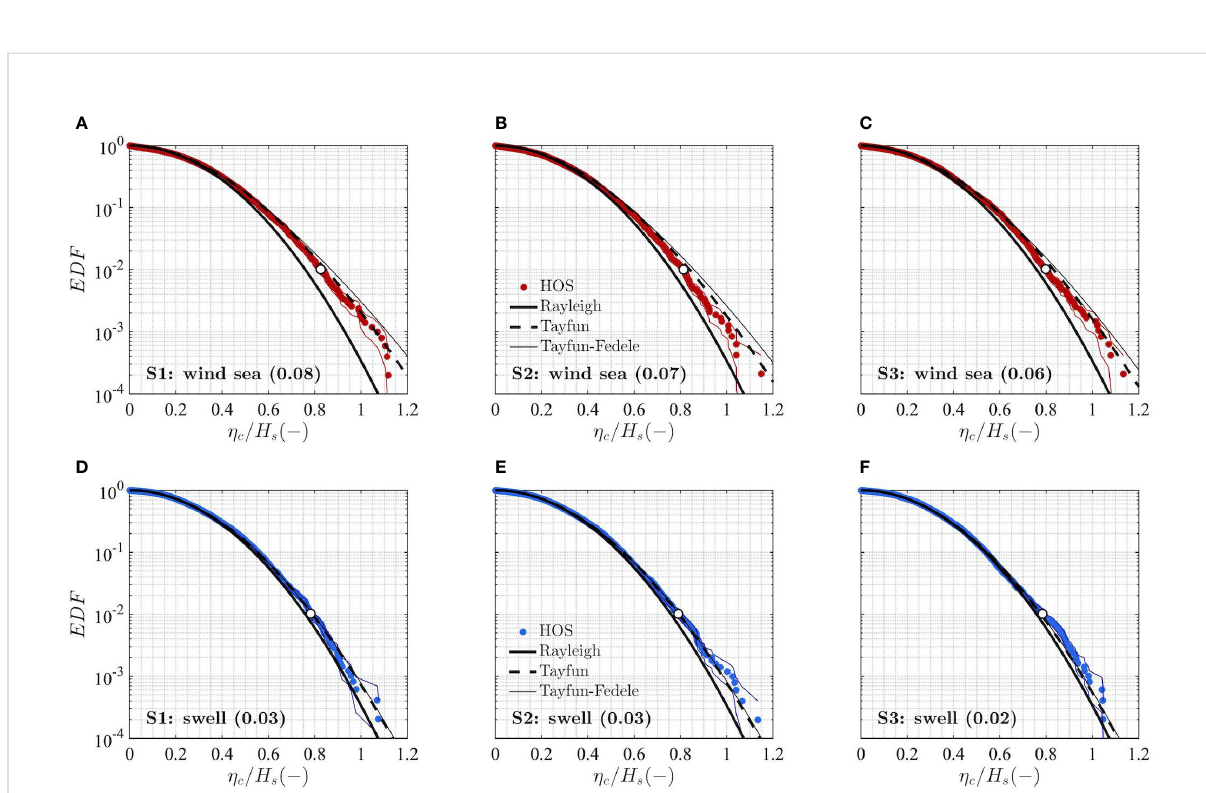
FIGURE 5 Empirical exceedance distribution functions of dimensionless crest heights ( h c /H s ) at a fi xed point of the numerical domain for wind sea (A – C) and swell (D – F) partitions identi fi ed within sea conditions S1, S2 and S3. The 99 th percentile (white circle) and the empirical EDF stability band (solid line) are also highlighted. Reference statistical distributions at a fi xed point: linear (Rayleigh, solid black), second-order (Tayfun, dashed black) and third-order (Tayfun- Fedele, solid grey). In brackets we display the value of the steepness m de fi ned in Eq. (8).